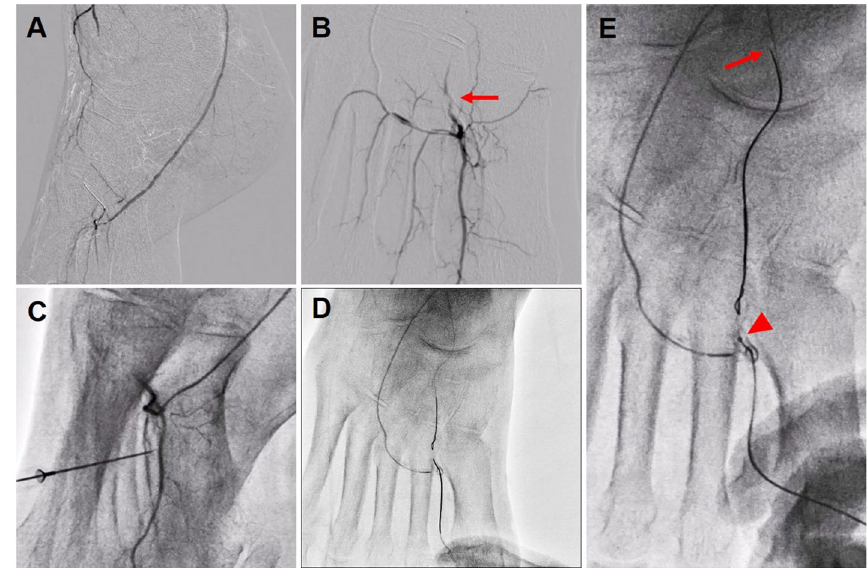
Fig. 2 a , b Visualization of the pedal arch by microcatheter tip injection. Arrow indicating the distal end of the dorsal artery (DA) occlusion. c Second distal puncture of the first dorsal metatarsal artery for retrograde access. d Gladius MG guidewire penetration into the occluded DA. e The retrograde Naveed Hard30 guidewire advancement as far as distal ATA (Arrow). However, Corsair Armet microcatheter could not follow the guidewire